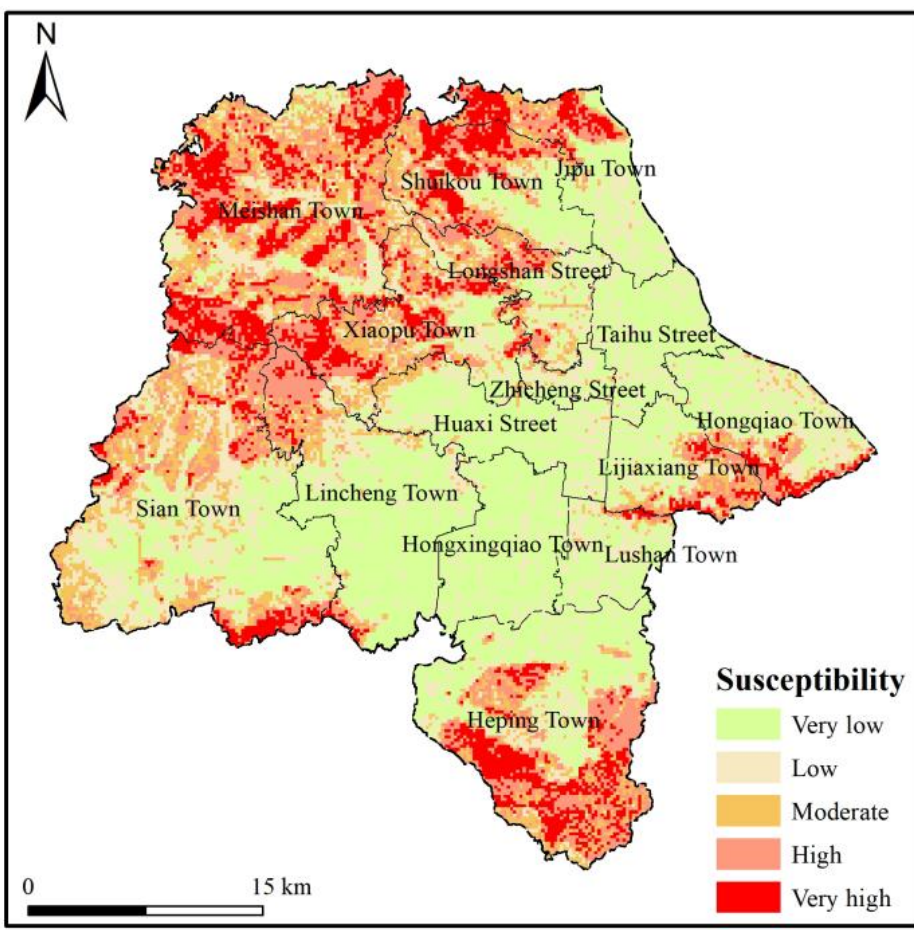
Figure 7. Regional division-information value model susceptibility evaluation zone map. The changes in information values, the graded area of each evaluation factor and the distribution of hazard points at the global level and in each local area are shown in Figure 8.